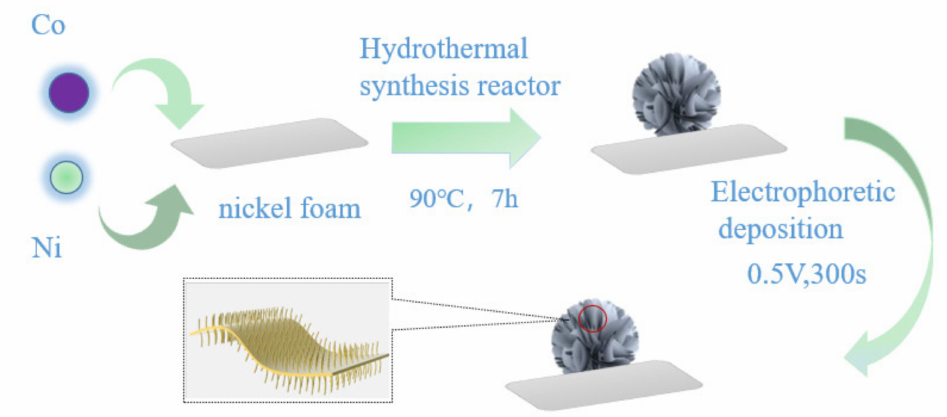
Figure 1. NiCo(OH) 4 -NiO preparation